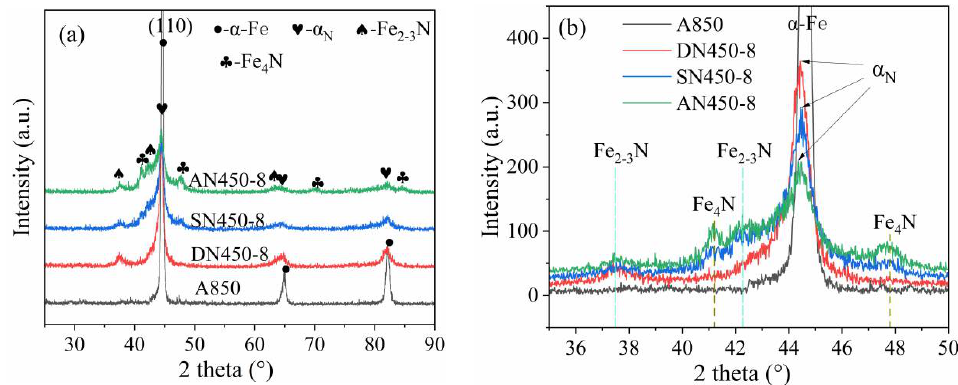
Figure 5. XRD patterns of AISI 430 ferritic stainless steel with a different initial microstructure before and after low-temperature plasma nitriding. ( a ) Different processes, and ( b ) diffraction angle range 35–50°.